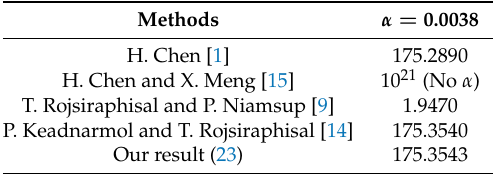
Table 10. Maximum allowable upper bounds σ of Example